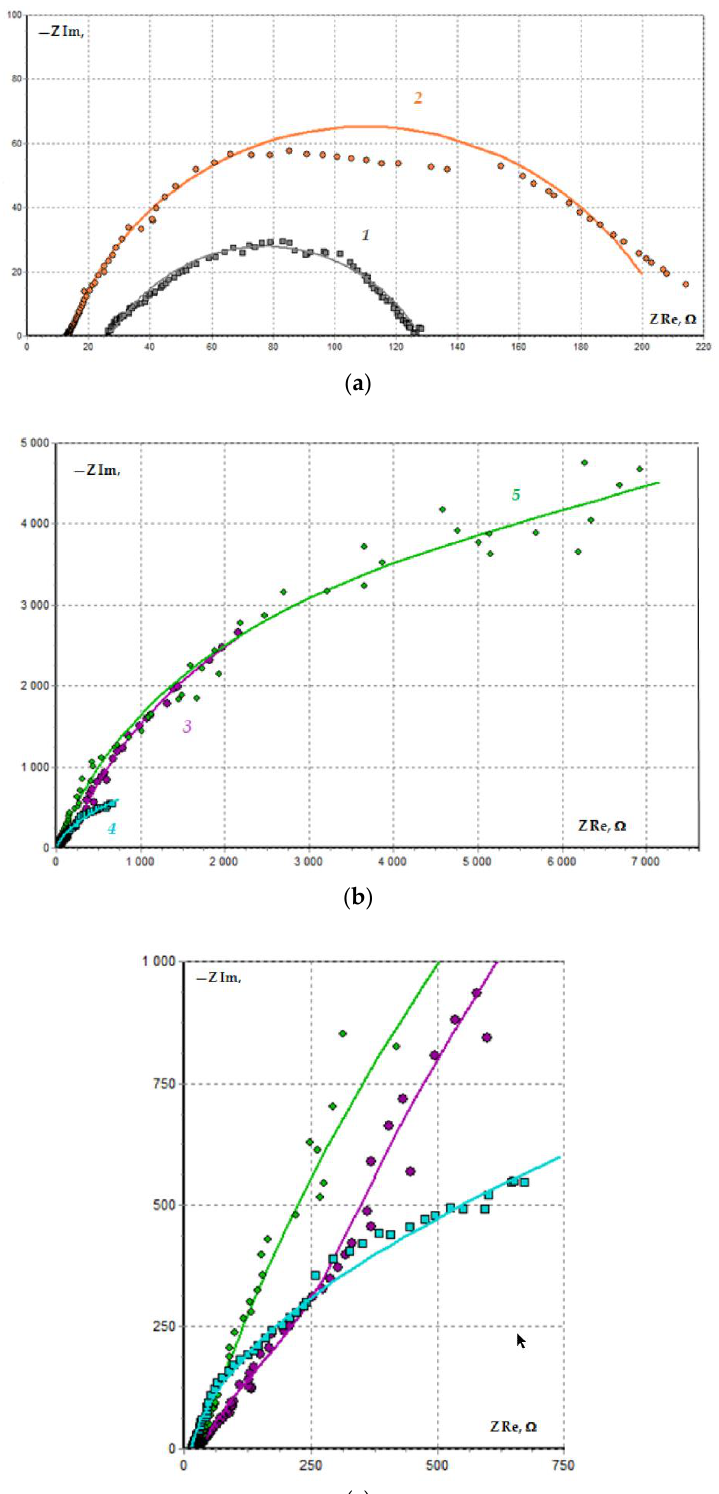
Figure 12. Nyquist plots of steel electrode: ( a ) before modifying (1) and after modifying the surface with 1% VS (2); ( b ) with 1% AS (3), 1% VS + 1 mM BTA (4) and 1% VS + 1% AS (5); ( c ) increased high frequency section. (Comparison between measured and simulated spectra. Dotted lines represent measured spectra and solid lines represent simulated spectra).